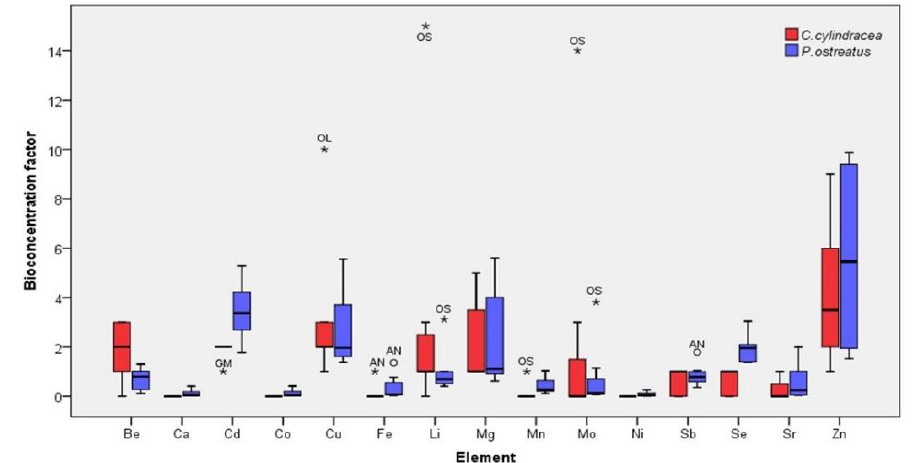
Figure 4. Box plot depicting bioconcentration factors of 15 elements in Cyclocybe cylindracea and Pleurotus ostreatus mushrooms produced on various substrates. AN: almond and walnut shells 1:1 w / w ; CC: corn cobs; GM: grape marc plus cotton gin trash 1:1 w / w ; OL: olive mill by-products (leaves and two-phase olive mill waste 1:1 w / w ); OS: extracted olive-press cake; PL: date-palm tree leaves; PN: pine needles. The size of each box represents 50% of the values, the black horizontal line represents the median, and the error bars the greatest and least values. Circles and asterisks indicate extreme values higher than 1.5 and up to 3 times, and more than 3 times, respectively.